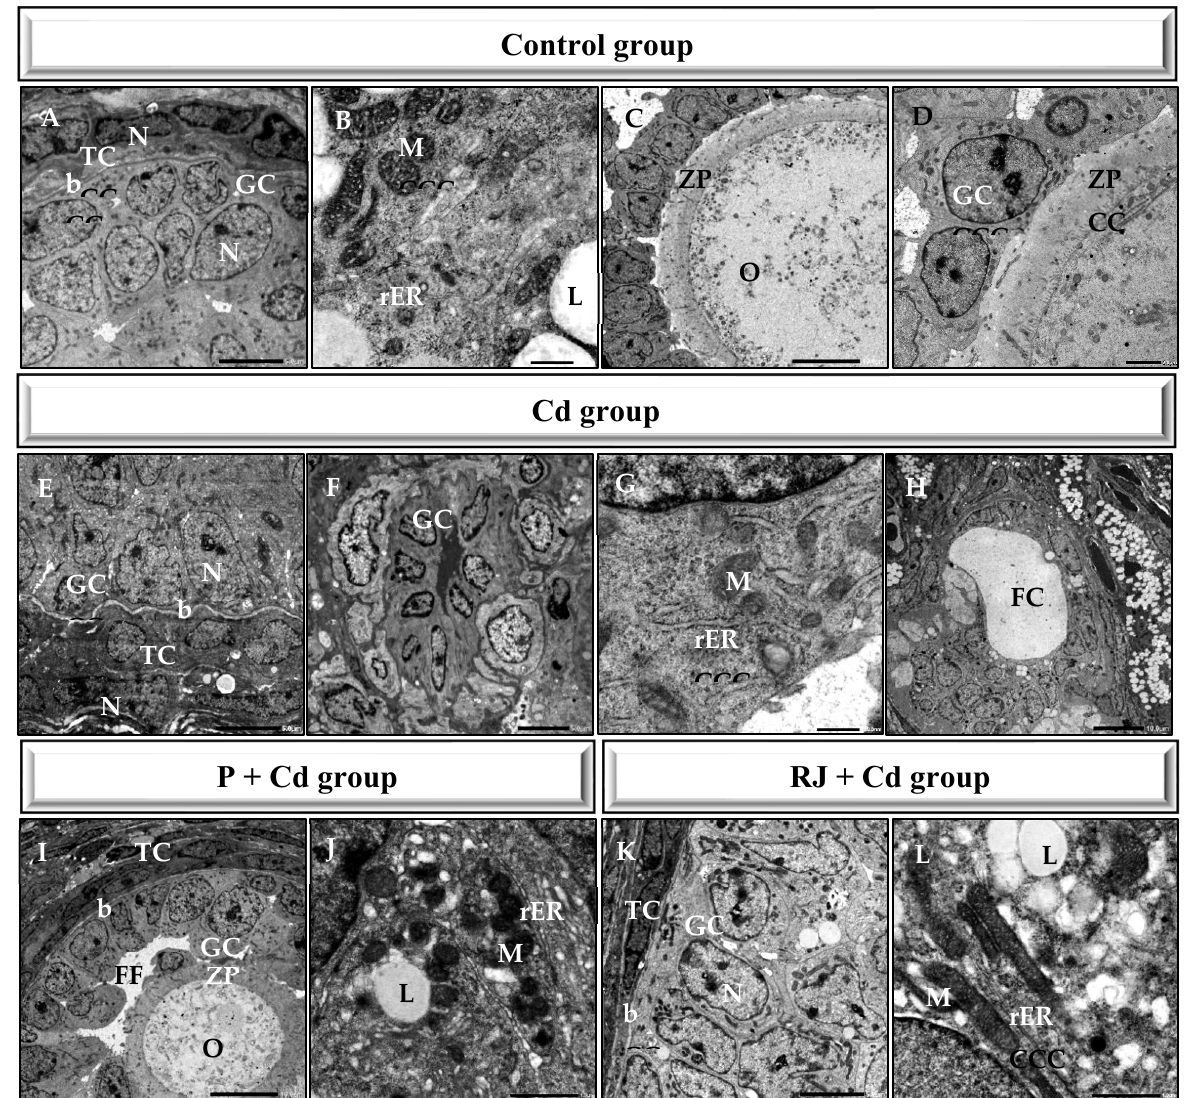
Figure 5. Transmission electron micrographs of ovaries from different experimental groups. b—basement membrane, FC—follicular cyst, FF—follicular fluid, GC—granulosa cell, L—lipid, M—mitochondria, N—nucleus, O—oocyte, rER—rough Endoplasmic Reticulum, TC—theca cell, ZP—zona pellucida .